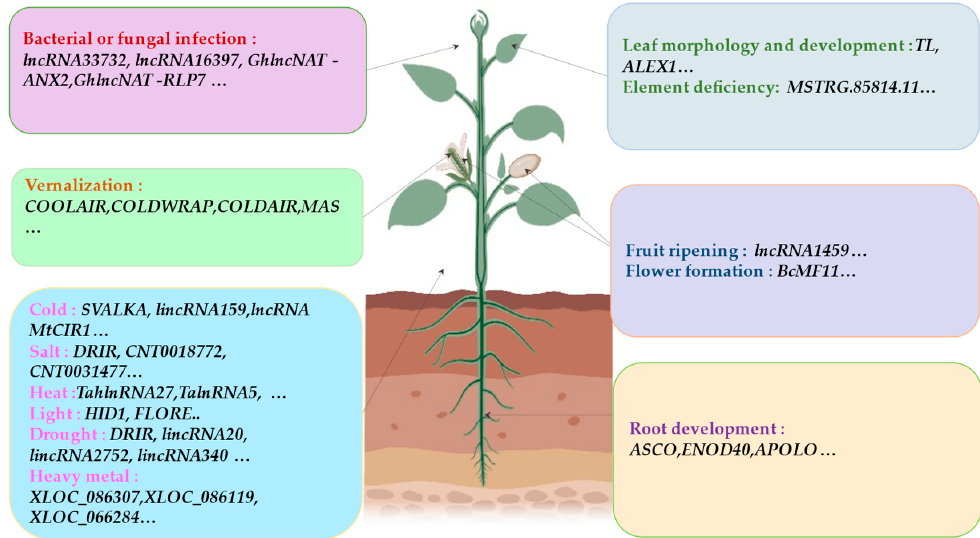
Figure 4. The role of lncRNA in plant growth and stress response. lncRNA33732 and lncRNA16397 respond to pathogen infection [97,98]. GhlncNAT-ANX2 and GhlncNAT-RLP7 are a pair of lncNRAs that regulate pathogenic infection and are involved in enhancing cotton disease resistance [99].